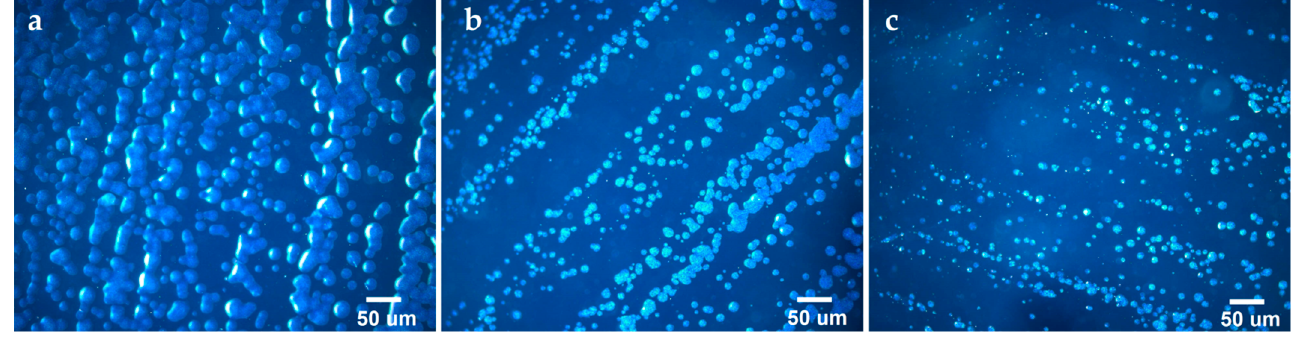
Figure 12. Fluorescence optical microscope images of S. aureus , illustrating the different degrees of bacterial colony growth: ( a ) total growth; ( b ) slightly stunted growth; ( c ) strongly stunted growth.